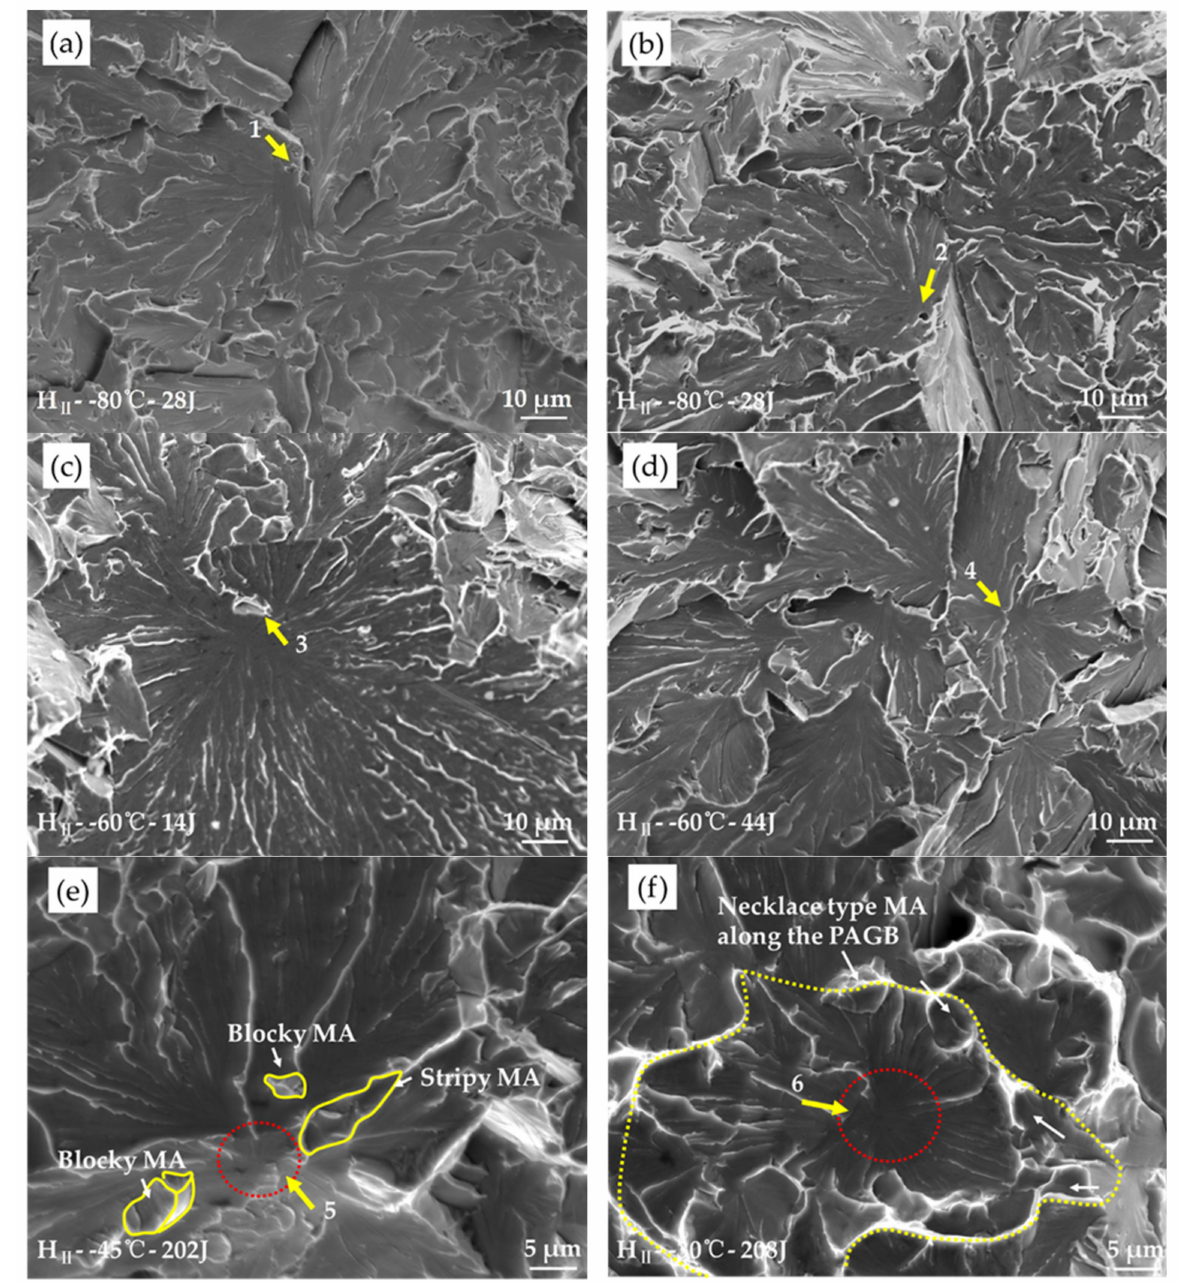
Figure 8. The typical cleavage crack initiation sites of H II samples at different test tempera- tures. ( a ) and ( b ) the two matching fracture surfaces of H II : − 80 ◦ C-28 J; ( c ) H II : − 60 ◦ C-14 J; ( d ) H II : − 60 ◦ C-44 J; ( e ) H II : − 45 ◦ C-202 J; ( f ) H II : − 30 ◦ C-208